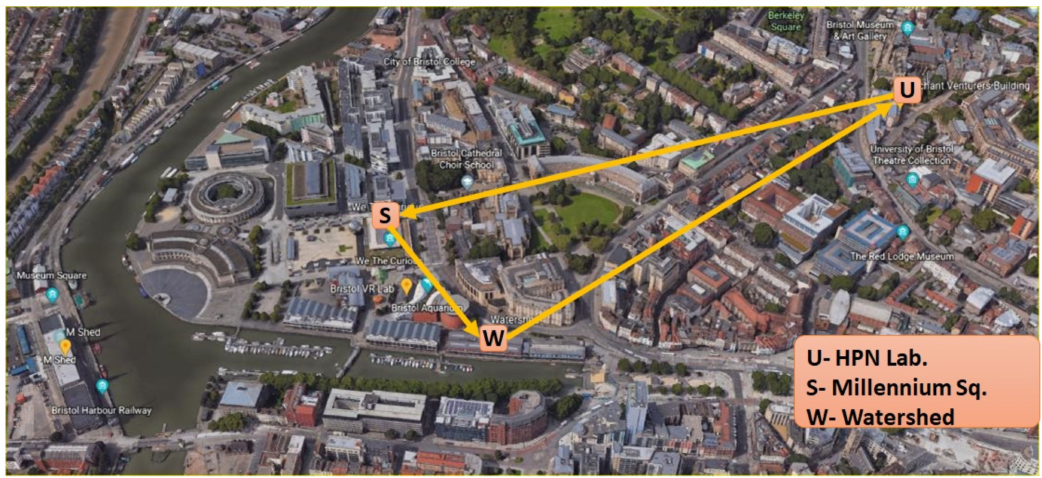
Figure 14. The Smart Internet Lab’s 5G test network (5GUK test network) ring topology to evaluate the TSON edge nodes. HPN: High Performance